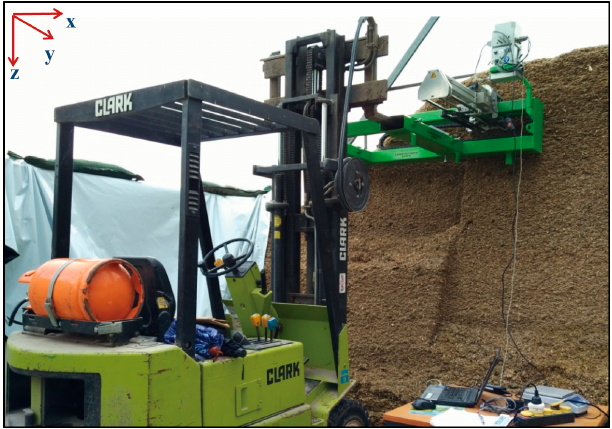
Figure 3. Using a forklift to position the frame prior to penetrating the face of the bunker silo at different heights.